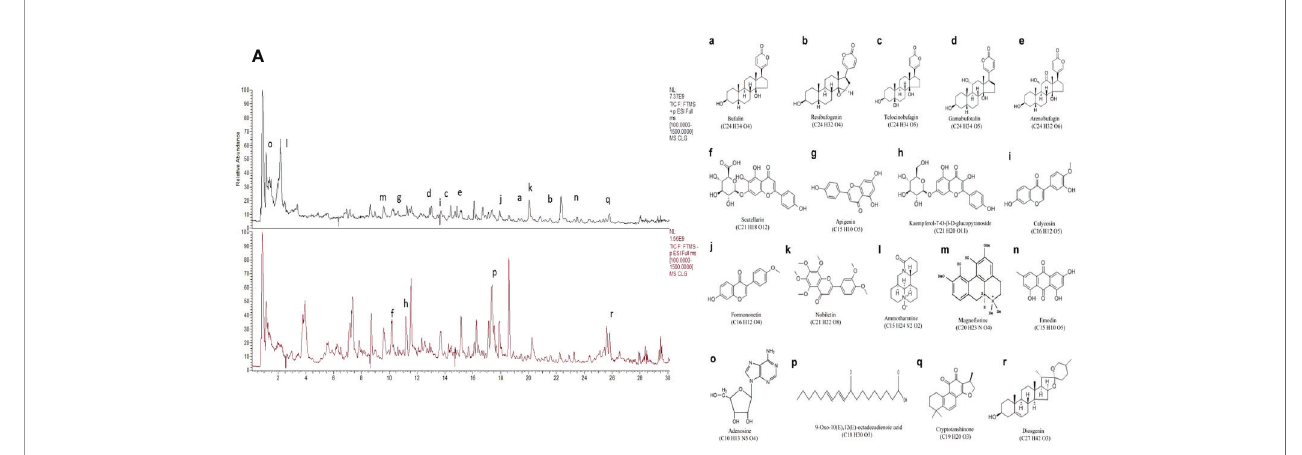
FIGURE 1 | The identi fi cation of the active compounds of CLG as determined by HPLC. (A) . HPLC of CLG. a . Bufalin. b . Resibufogenin. c . Telocinobufagin. d . Gamabufotalin. e . Arenobufagin. f . Scutellarin. g . Apigenin. h . Kaempferol-7-O- b - D -glucopyranoside. i . Calycosin. j . Formononetin. k . Nobiletin. l . Ammothamnine. m . Magno fl orine. n . Emodin. o . Adenosine. p . 9-Oxo-10(E),12(E)-octadecadienoic acid. q . Cryptotanshinone. r .